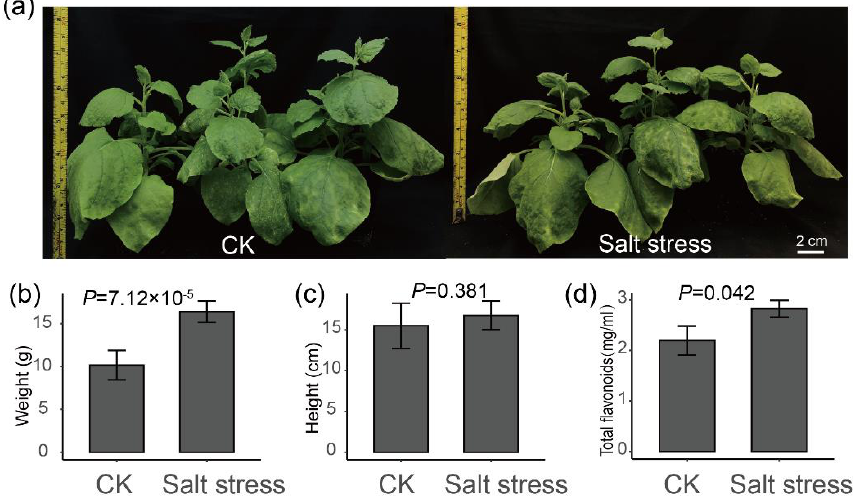
Figure 6. Plant height, fresh weight and total flavonoid content of tobacco under salt stress. ( a ) The phenotypic changes in tobacco plant after 14 days of salt stress. ( b ) The fresh weight of the aerial part of tobacco. ( c ) The height of the tobacco. ( d ) Total flavonoid content of tobacco.